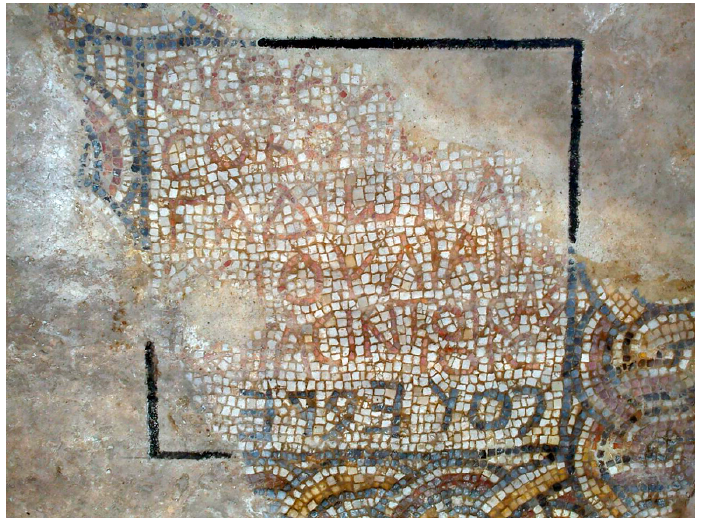
Figure 6. Apollonia-Arsuf, Area P1, the inscription, photo (close-up, after restoration). The Greek letters were made of red tesserae and those of the Samaritan inscription were made of black tesserae . While the Greek inscription is composed of five rows (and an uneven additional row with the suffix of the last word), that of the Samaritan inscription has one row. Based on the division of the letters of